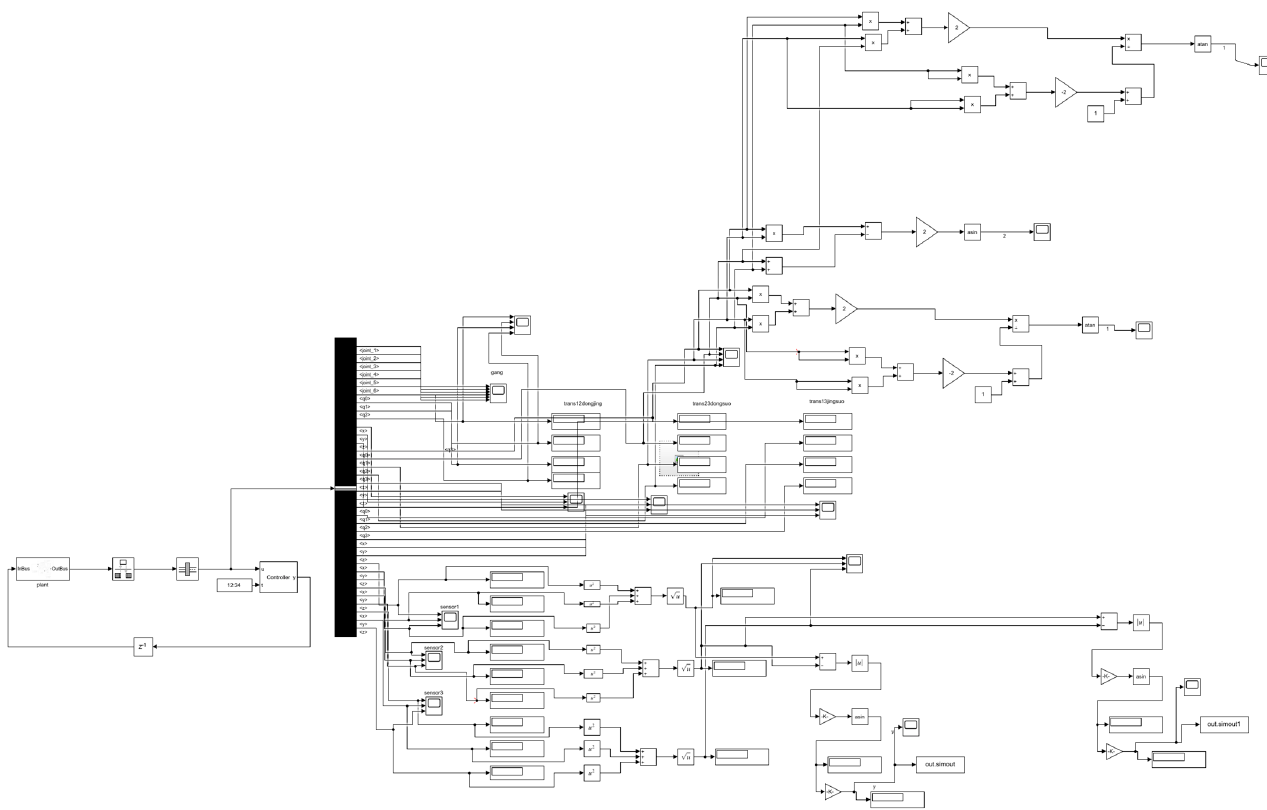
Figure A1. Overall block diagram of docking mechanism.